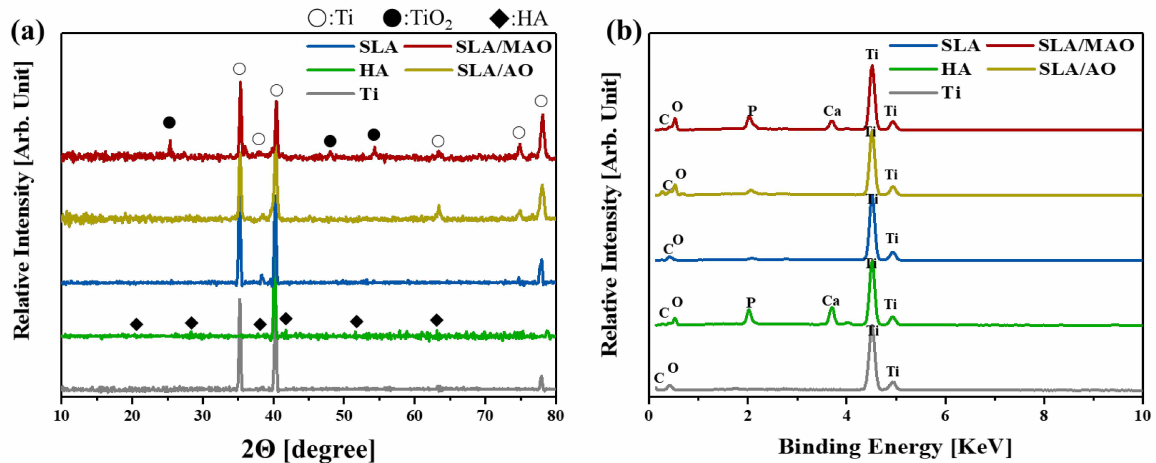
Figure 3. Component analysis of surface-modified titanium through ( a ) X-ray diffraction (XRD) and ( b ) energy-dispersive X-ray spectroscopy (EDS) analyses.